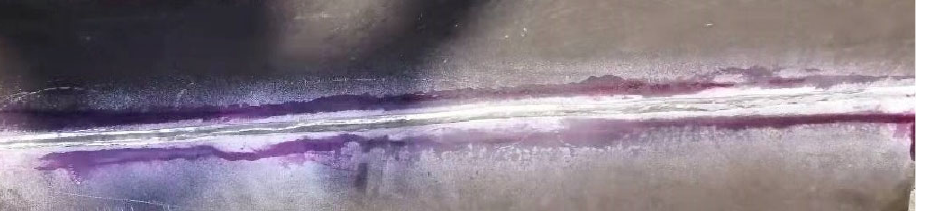
Figure 7. Surface penetration detection of the SM ‐ 1 welded joint. Table 6. Macroscopic examination results of the investigated welded joints.